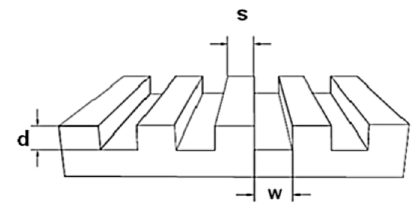
Figure 1. Structure of a silicon master.